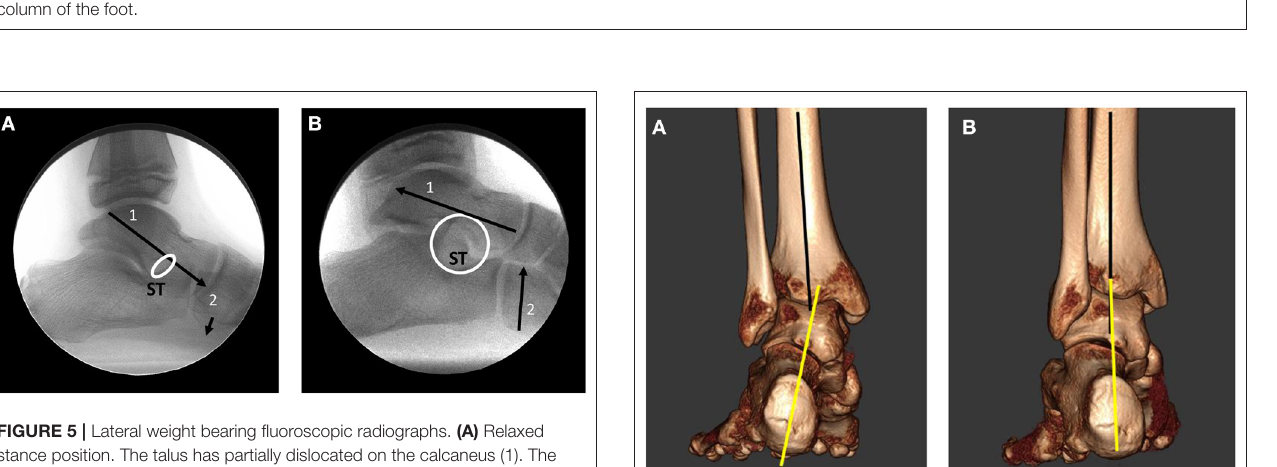
FIGURE 4 | Schematic showing the portions of the gait cycle with an unstable, partially dislocated talotarsal joint (TTJ). The TTJ remains in a pronated, unlocked position longer than normal. “FFC” is full plantar foot contact. The joints and soft tissues will be forced to compensate for the excessive forces acting on the medial column of the foot.